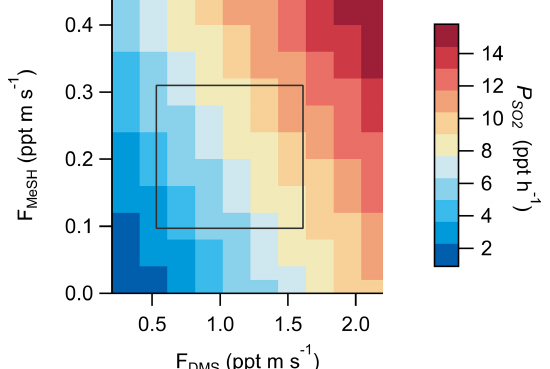
) in the marine 2